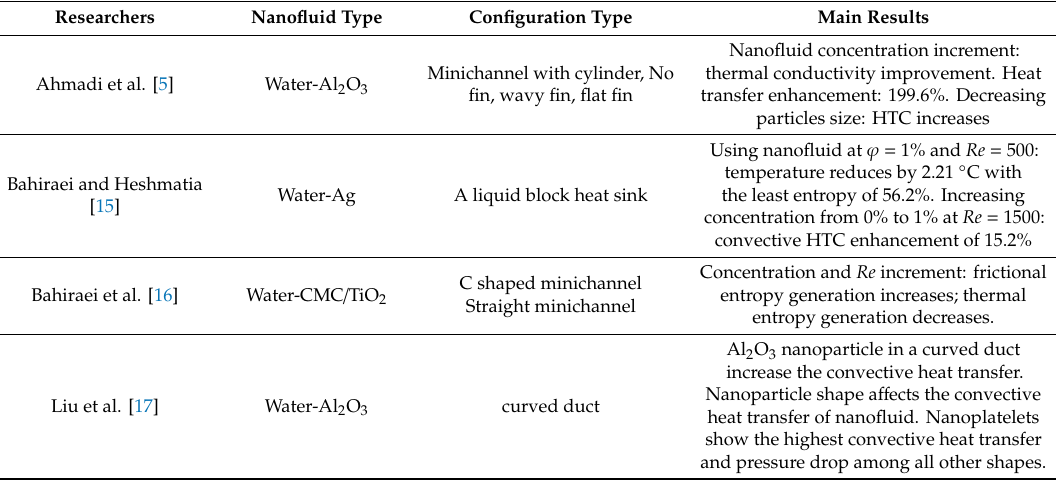
Table 1. Studies on employing nanofluids in di ff erent